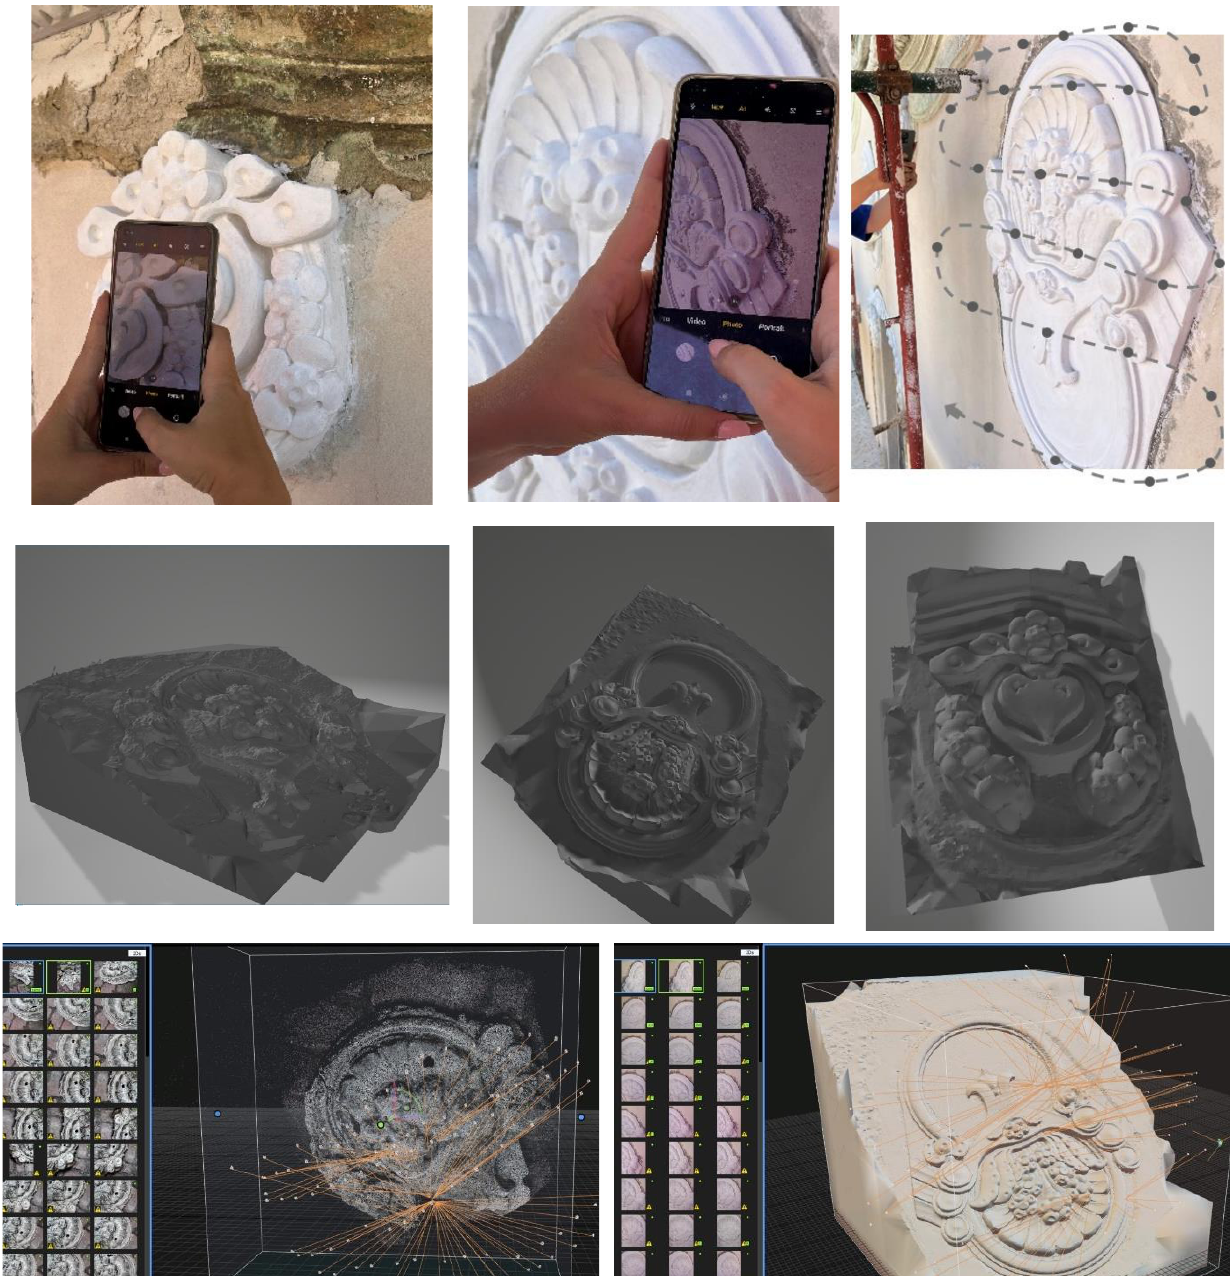
Figure 13. Photogrammetry of two different ornaments from the Lajos (Ludwig) Besch and Károly (Karl) Piffl Palace, the crisscross trajectory of the pictures, and the 3D results.